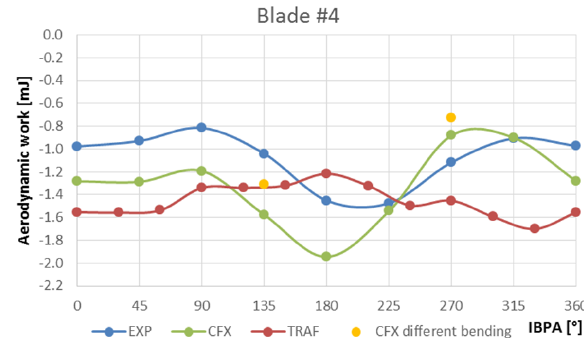
Figure 15. Aerodynamic work of blade bending motion - blade #3: experimental (EXP), CFX and TRAF comparison.